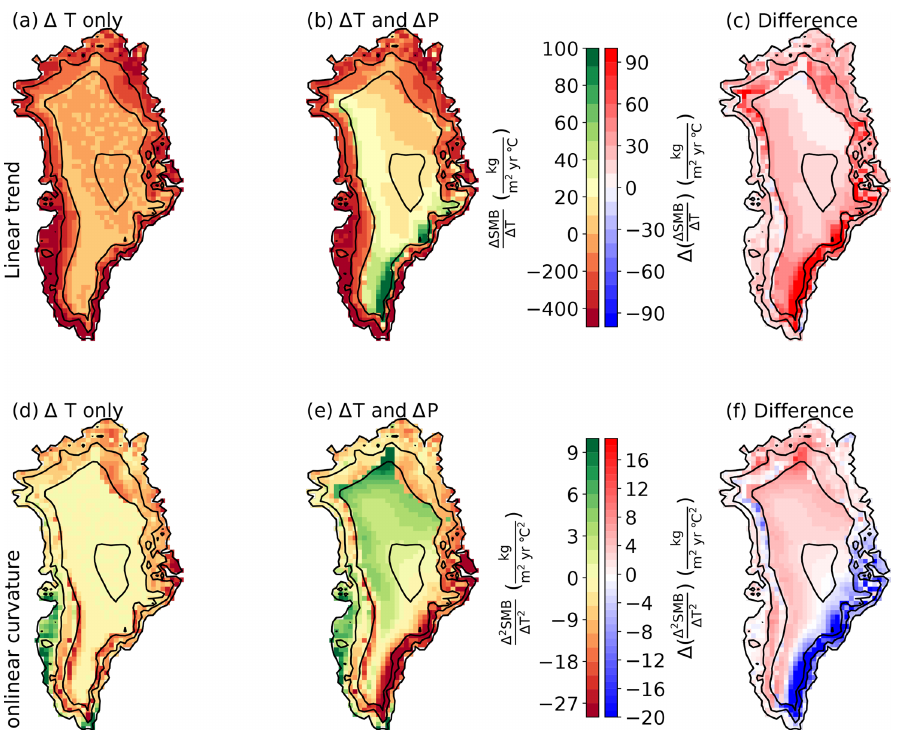
Figure 14. Spatial distribution of linear trend (a, b) and curvature (d, e) of the SMB anomalies as a function of perturbations in the annual mean temperature for simulations that were perturbed with the temperature anomalies alone (a, d) , simulations that were perturbed by both anomalous temperature and corresponding precipitation (b, e) , and the respective differences (c, f)